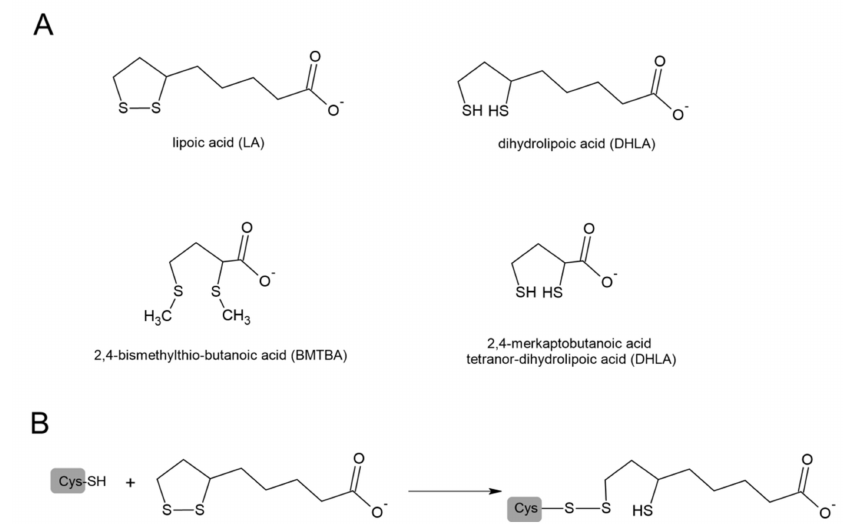
Figure 8. ( A ) Structures of lipoic acid (LA), dihydrolipoic acid (DHLA), and products of its biotransfor- mation: 2,4–bismethylthio-butanoic acid (BMTBA) and tetranor-dihydrolipoic acid (tetranor-DHLA). ( B ) Modification of Cys residue by LA through thiol–disulfide exchange (modified from